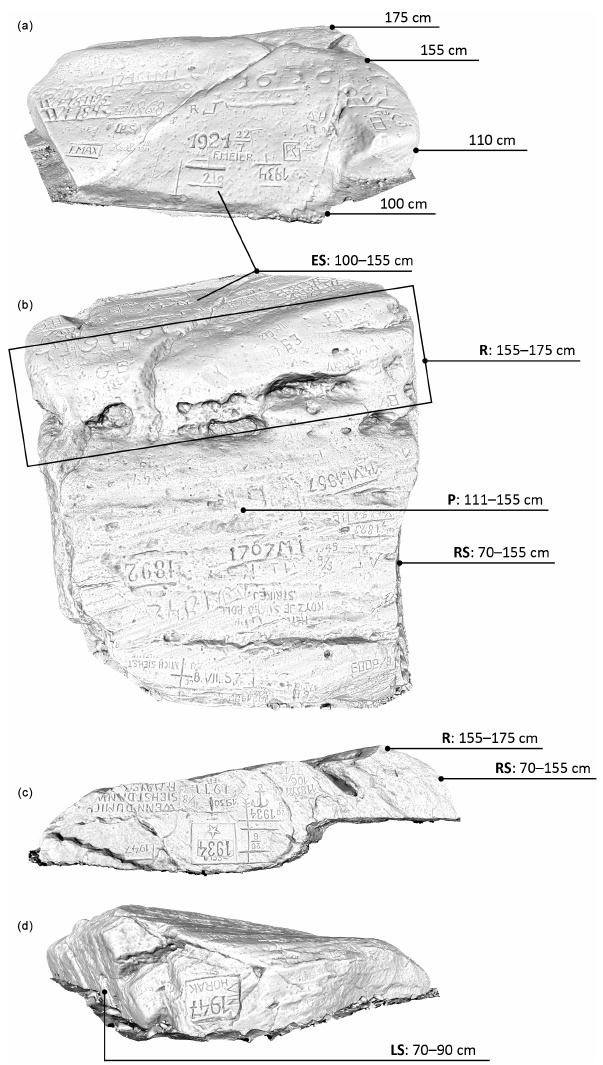
Figure 4. The hunger stone was divided into four height ranges (Table 4) and the following sides (a–d) : embankment side (ES), the highest part of the stone’s ridge (R), platform (P), right side (RS) and left side